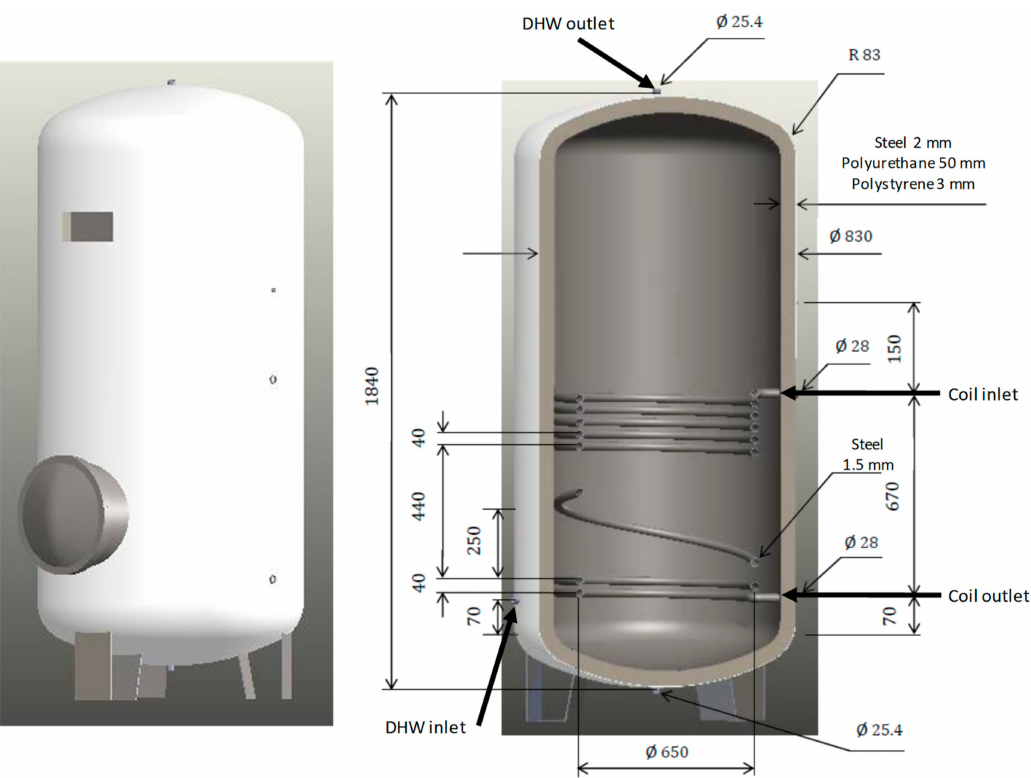
Figure 1. Geometry of the bu ff er tank